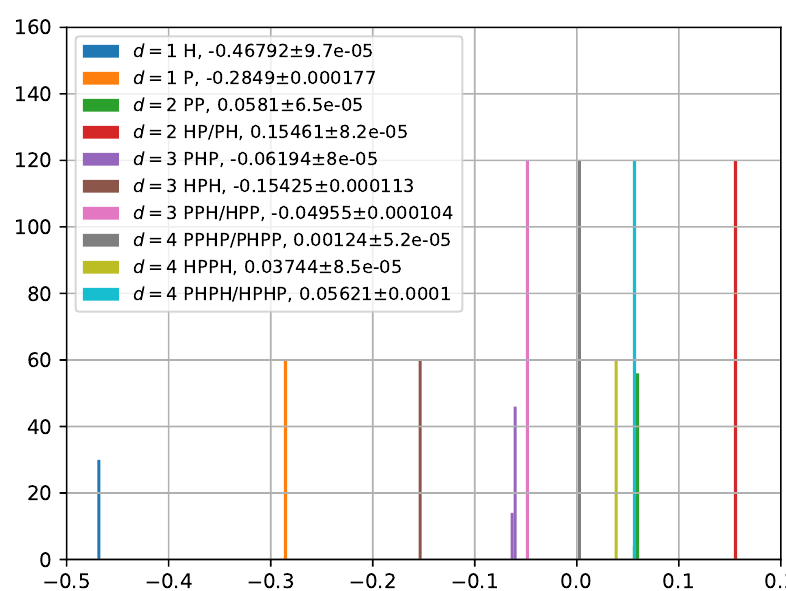
〉 in the ground state d bonds. For the meaning of 60